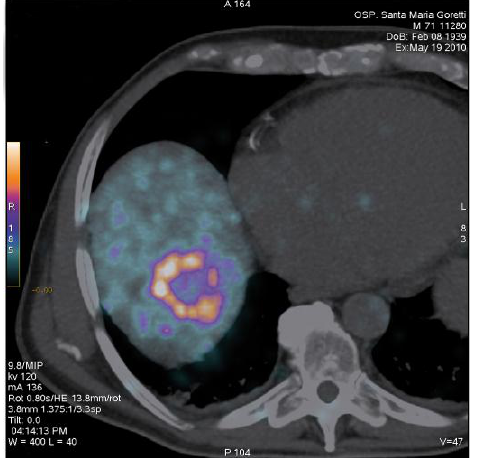
Figure 4. PET acquisition of β + particles emitted in the 0 + /0 + transition of 90 Zr. The biodistribution of resin microspheres after liver radioembolization is shown (courtesy of Dr. Oreste